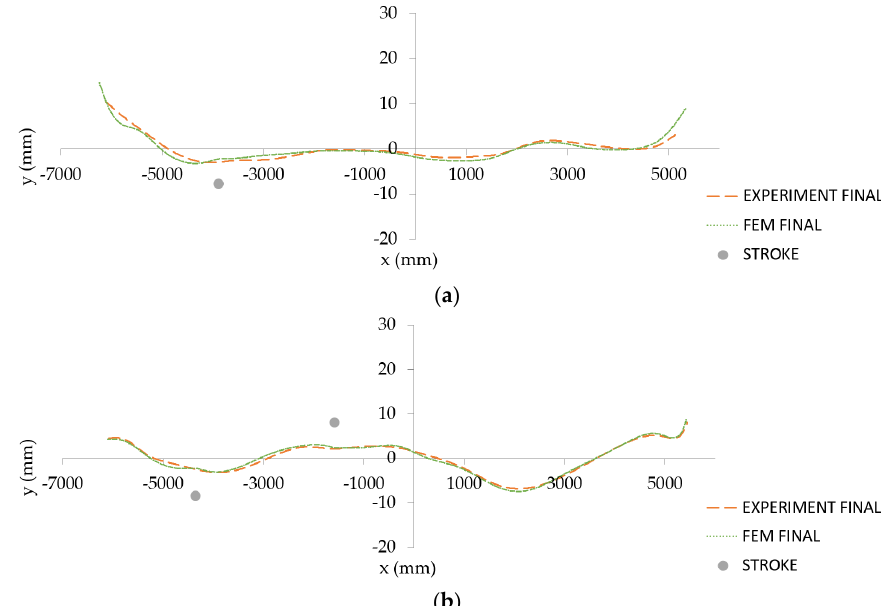
Figure 16. Comparison of experimental and predicted final shapes of two exemplary billets: “single-arc” type ( a ) and “S-shaped” type ( b ).